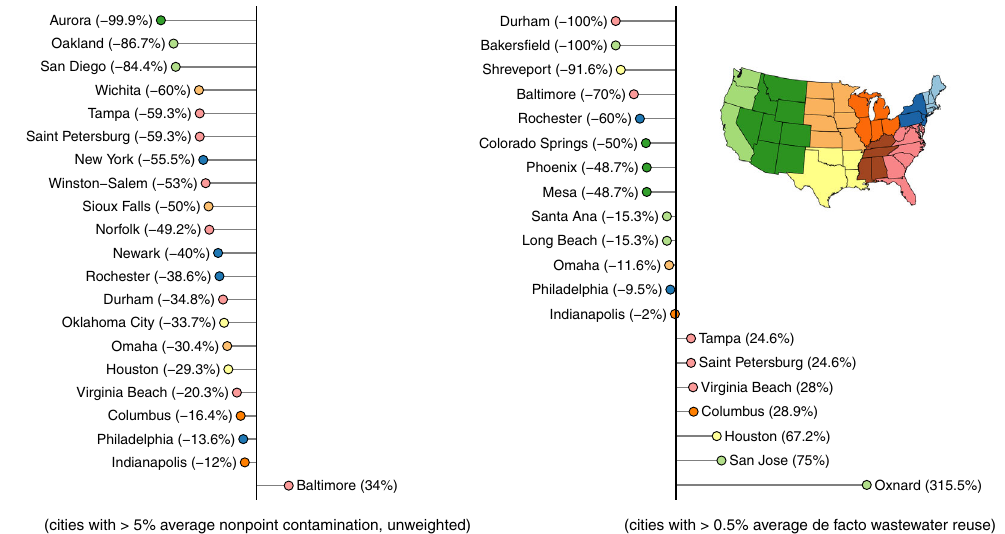
Fig. 5 Source diversity and reliance matters. a Displays the impact of watershed weighting on nonpoint PPCS, while b displays the impact of watershed weighting on point PPCS. These results show the % impact on Point and Nonpoint PPCS relative to the same metrics but calculated assuming equal weighting of supply across sources. Results are shown for cities with >5% average nonpoint contamination and cities with >0.5% average point contamination across contributing watersheds. This analysis excludes the in fl uence of groundwater. Point color gives U.S. Census division (see map